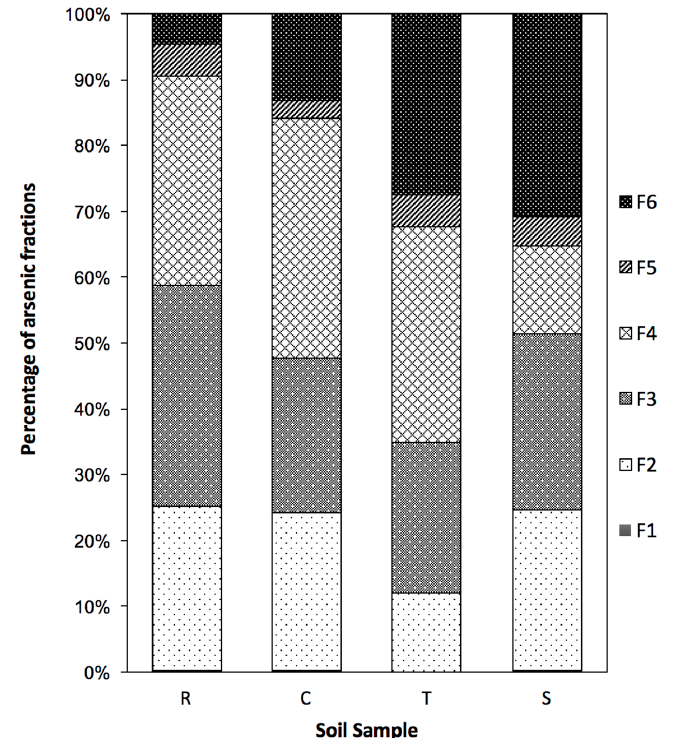
Figure 1. Speciation of arsenic using the modified sequential extraction method in four soil samples,